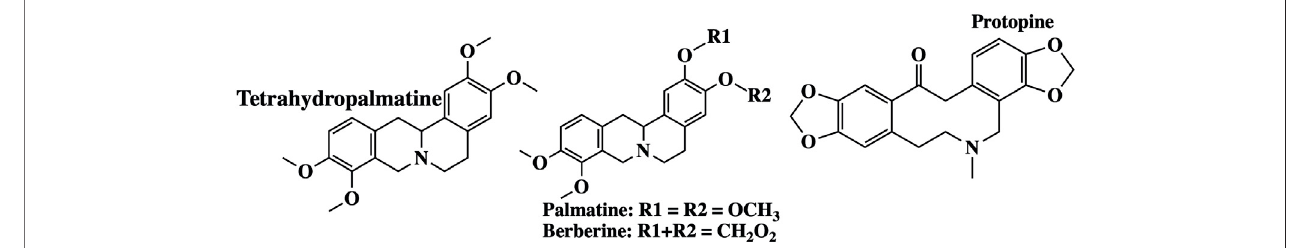
FIGURE 7 | Examples of molecular structures of alkaloids obtained from Corydalis yanhusuo